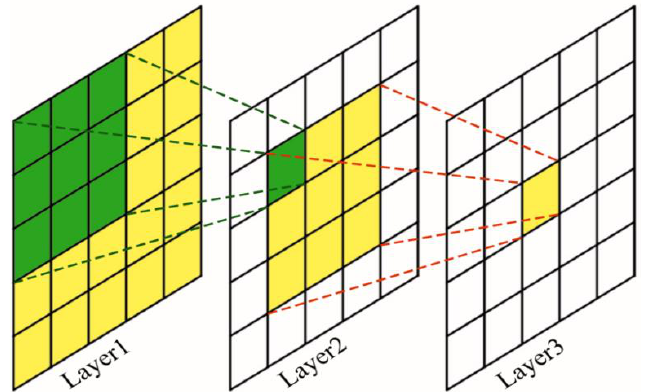
Figure 5. Receptive field.